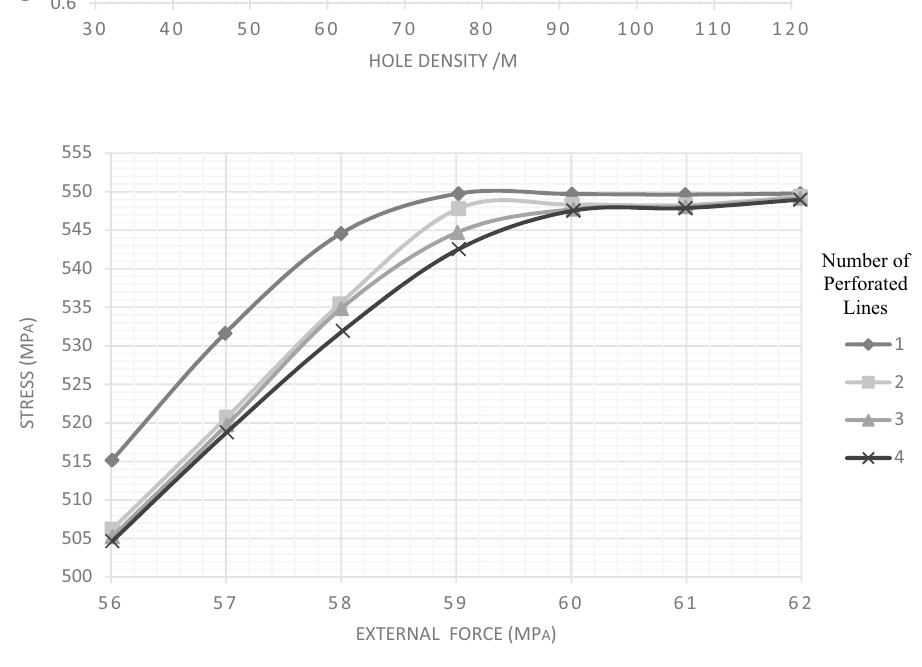
Fig. 10 Influence of different numbers of perforated lines on collapse resistance